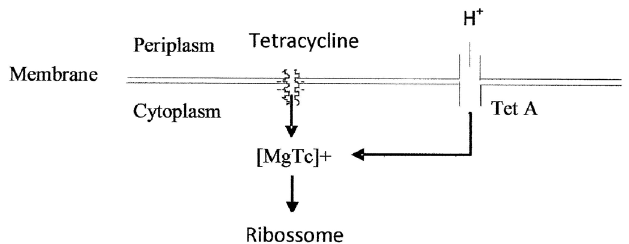
FIGURE 3 - Schematic diagram representing the efflux mechanism of bacterial resistance (Adapted from Pereira-Maia et al. ,